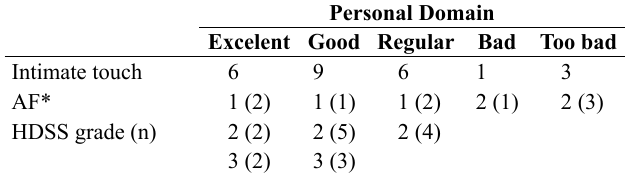
Table 4: Distribution of the functional-social domain of the 25 Phys- ical Education students with primary hyperhidrosis of a private uni- Table 5: Distribution of the personal domain of the 25 Physical versity of Aracaju-SE, from August to November 2017, according to Education students with primary hyperhidrosis from a private univer- the classification of the quality of life questionnaire (25,24) sity in Aracaju-SE, from August to November 2017, according to the classification of the quality of life questionnaire. (25.24) Functional-social domain